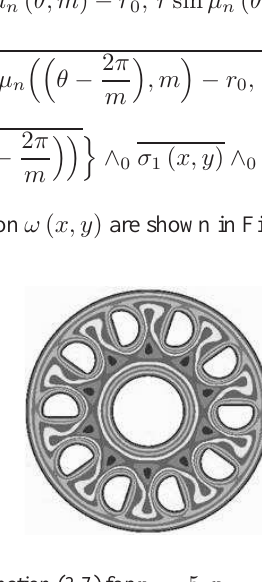
Figure 4. Contour lines of function (3.7) for r 0 = 5 , r 02 = 1 , a = 0 . 3 , m = 10